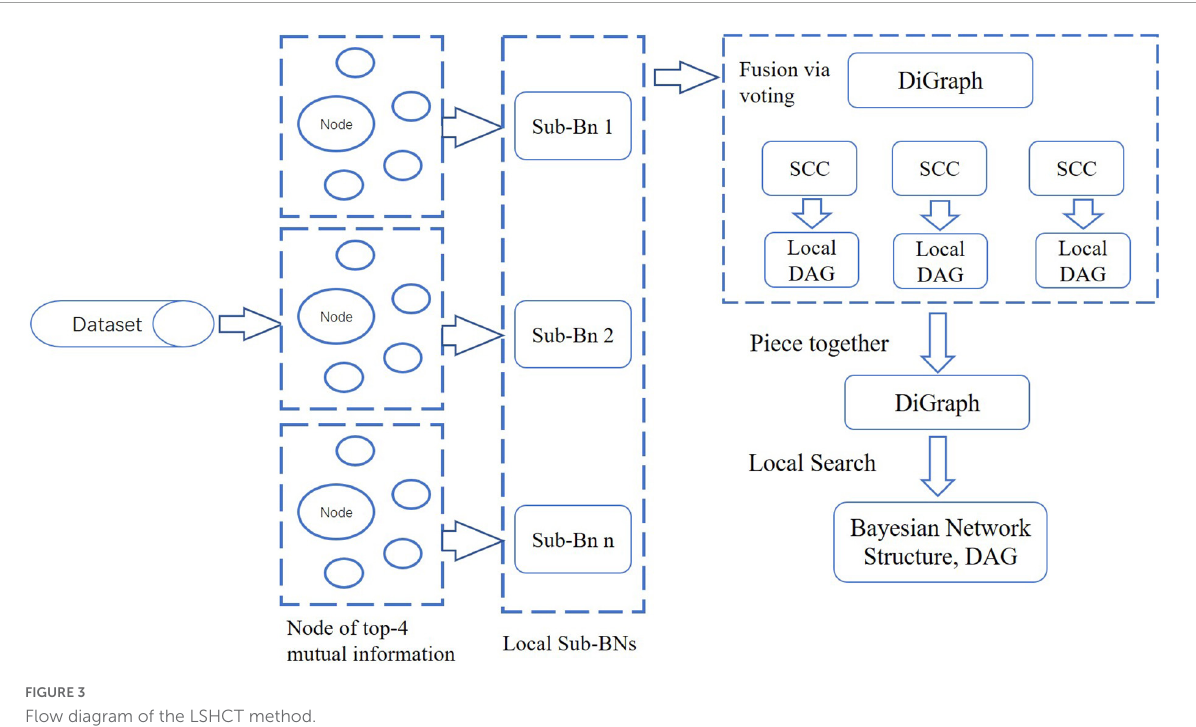
FIGURE3 Flow diagram of the LSHCT